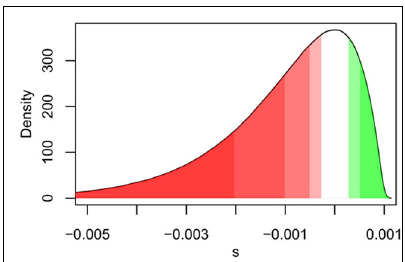
FIGURE 1 | A visual representation of the effect of increasing population size ( N e ) on the fraction of deleterious, neutral, and beneficial mutations, for a given potential realization of the distribution of fitness effects (DFE). As shown, the effective fraction of neutral mutations decreases with increasing N e with the darkest shades representing the proportion of deleterious (red) and beneficial (green) mutations for N e = 500, and increasingly lighter shades for ( N e = 1000, 2000, and 4000). The white shading centered around 0 represents mutations that are effectively neutral under all four population